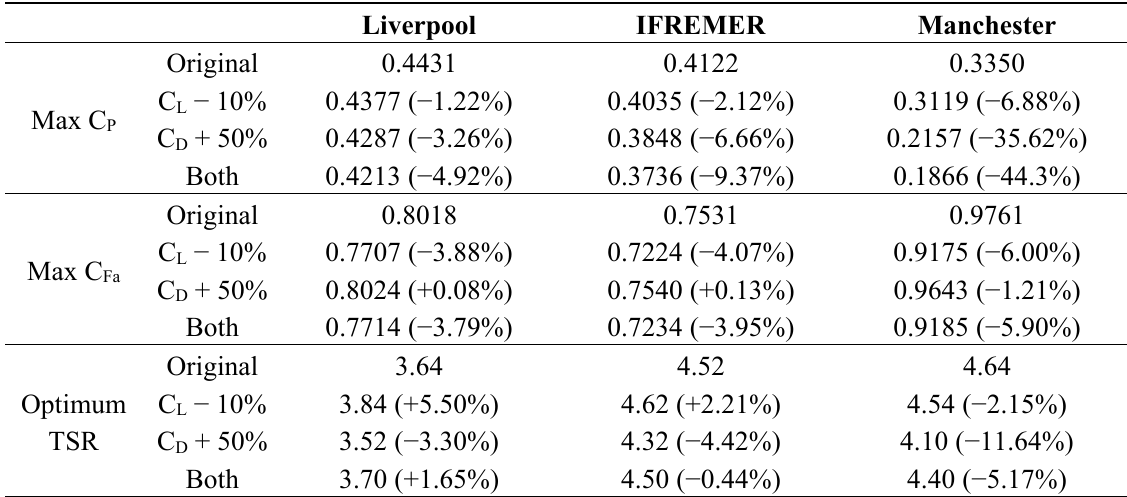
Table 1. Changes to maximum power and thrust coefficients and optimum TSR for Liverpool, IFREMER and Manchester turbines in response to small changes in the lift and drag properties of blade